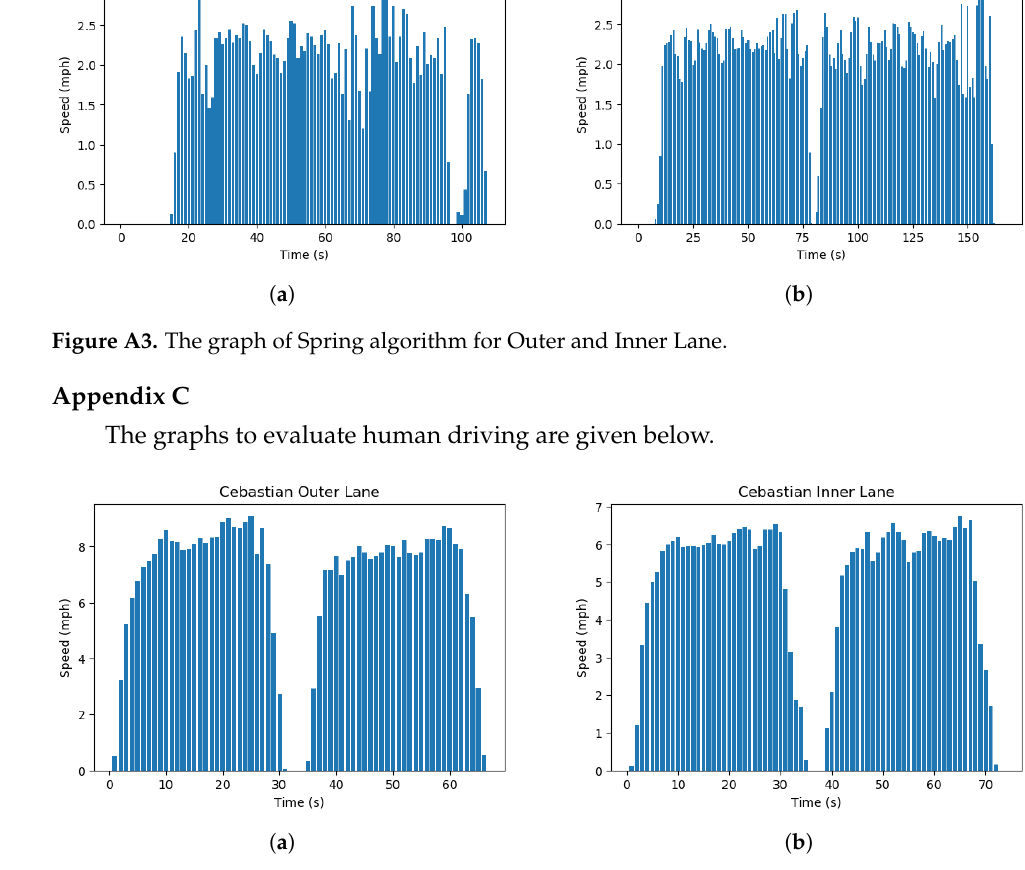
Figure A4. Author Cebastian Chinolla’s driving graphs for outer and inner lane.